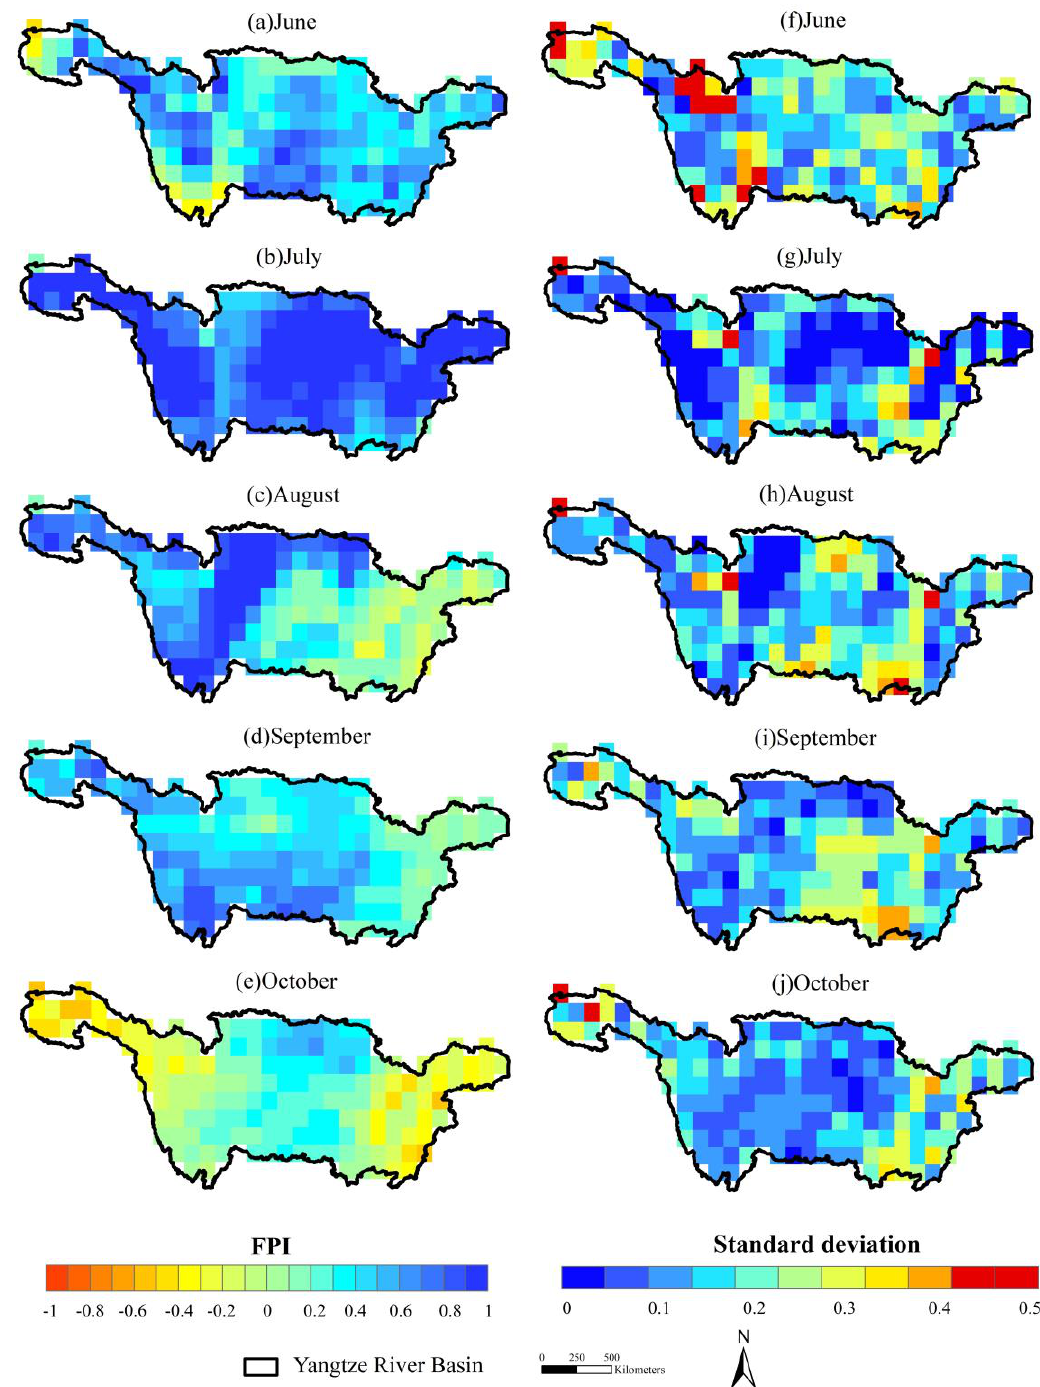
Figure 10. Monthly spatial distribution of ensemble means of FPI (left panel) and their standard deviation (right panel) in